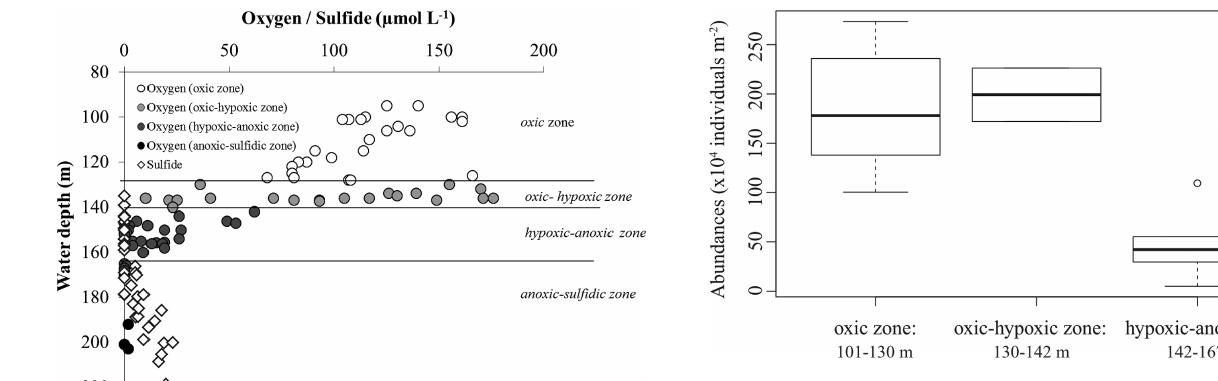
Figure 3. Abundance of meiobenthos in the upper 5cm of the sed- iment under different oxygen regimes. The middle line in each box depicts the median, while both whiskers and outliers indicate the distribution of remaining data